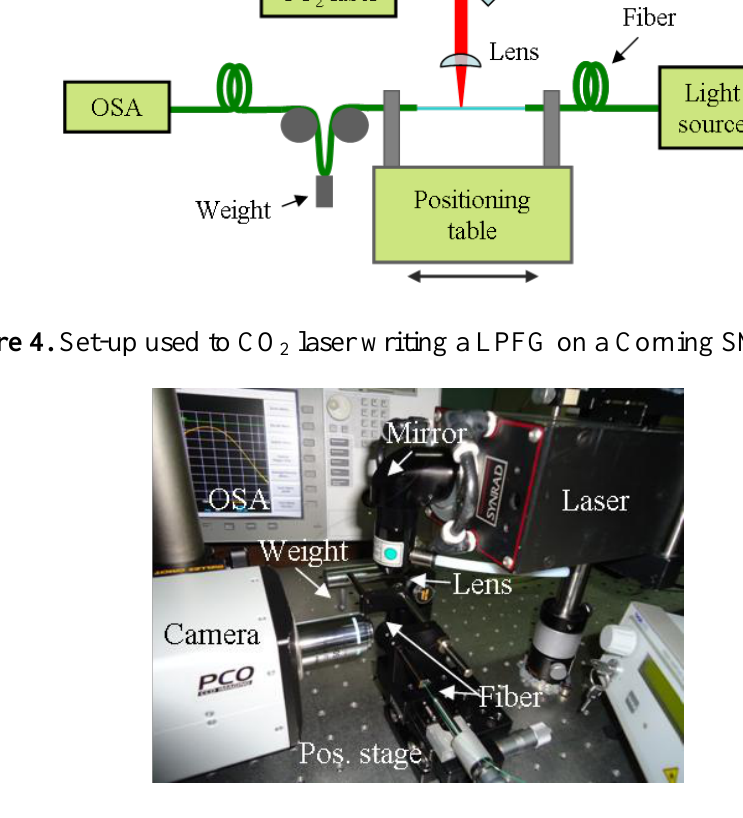
Figure 3. Schematic of the basic point-by-point set-up for laser writing of a LPFG.